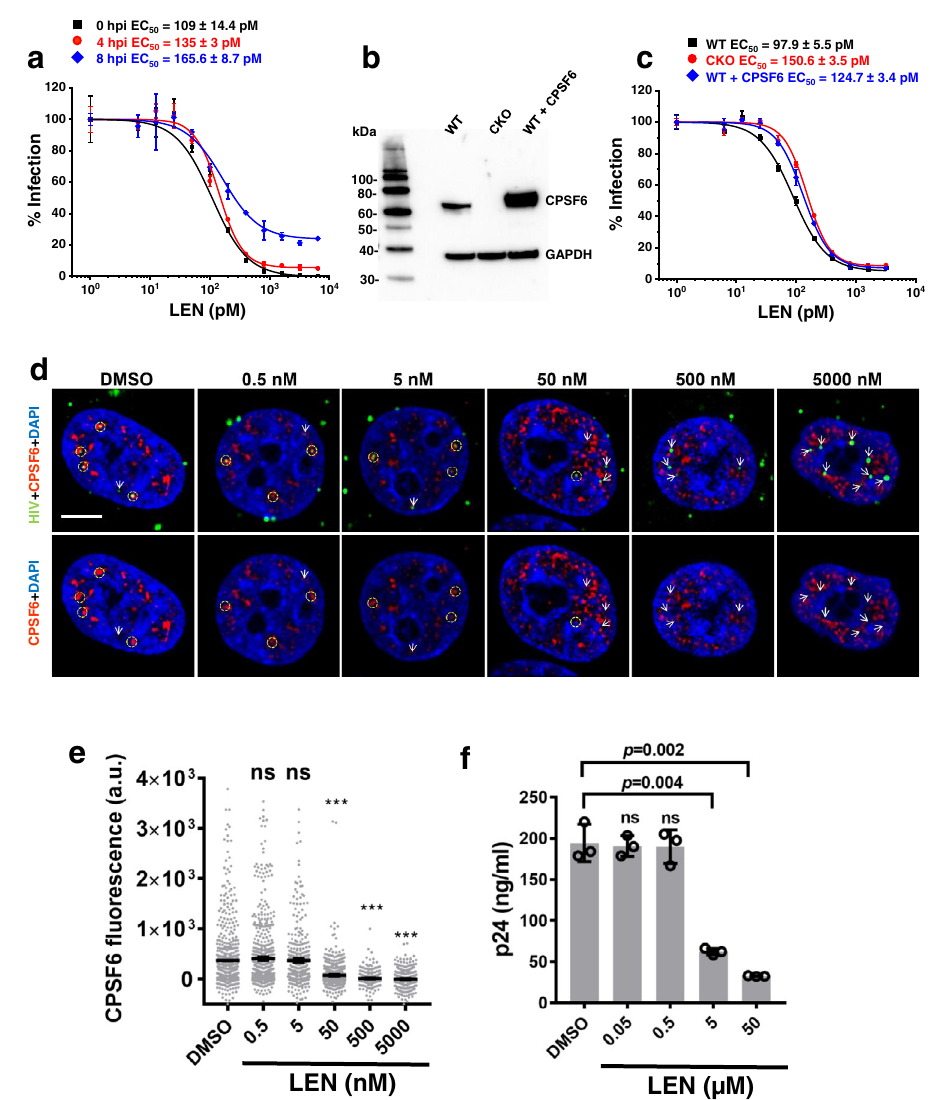
Fig. 9 | Interplay between LEN, CPSF6 and HIV-1. a Antiviral activities after LEN addition to HEK293T cells at indicated time points post-infection. The normalized andaverageddata(+/ − SD)fromthreeindependentexperimentsareshown.Source data are provided as a Source Data fi le. b Representative immunoblotting to show the expression levels of CPSF6 in parental, CPSF6 KO (CKO) and CPSF6 over- expressing HEK293T cells. The experiment was repeated 3 times independently withsimilarresults. c AntiviralactivitiesofLENinindicatedcellswithvaryinglevels of CPSF6. VSV-G pseudotyped HIV-scarlet viruses (MOI=0.5) were used to infect indicated cells. The infection levels in different cell lines without LEN treatment were 43.9±2% (WT), 38.5±0.9% (CKO) and 38.4±1.6% (WT+CPSF6). The nor- malized and averaged data (+/ − SD) from three independent experiments are shown in c . Source data are provided as a Source Data fi le. d TZM-bl cells were infectedwithINmNG-labeled fl uorescentHIV-1pseudovirusesfor8hto allow virus nuclear import 40 . At 8 hpi, cells were treated with DMSO or indicated concentra- tionsofLENfor30min, fi xedwithPFAandimmuno-stainedforendogenousCPSF6. SingleZ-sliceimagesshownuclearIN-puncta(green)andendogenousCPSF6(red). Yellow dashed circles and white arrows point to nuclear IN-puncta colocalized or